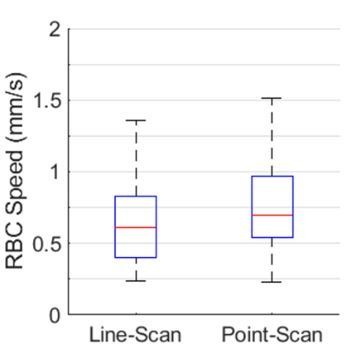
Comparison between the RBC speed measurements by the line-scan and point-scan method.The measurements were performed in 58 capillaries across two mice within cortical depth of 0-200 µm. The statistical comparison wascarried out using Student’s t-test, but no statistical significance was found.